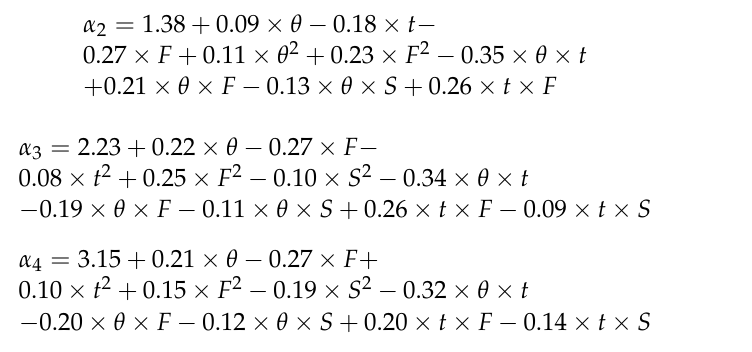
Table 4. Calculation of variance for testing the adequacy of the